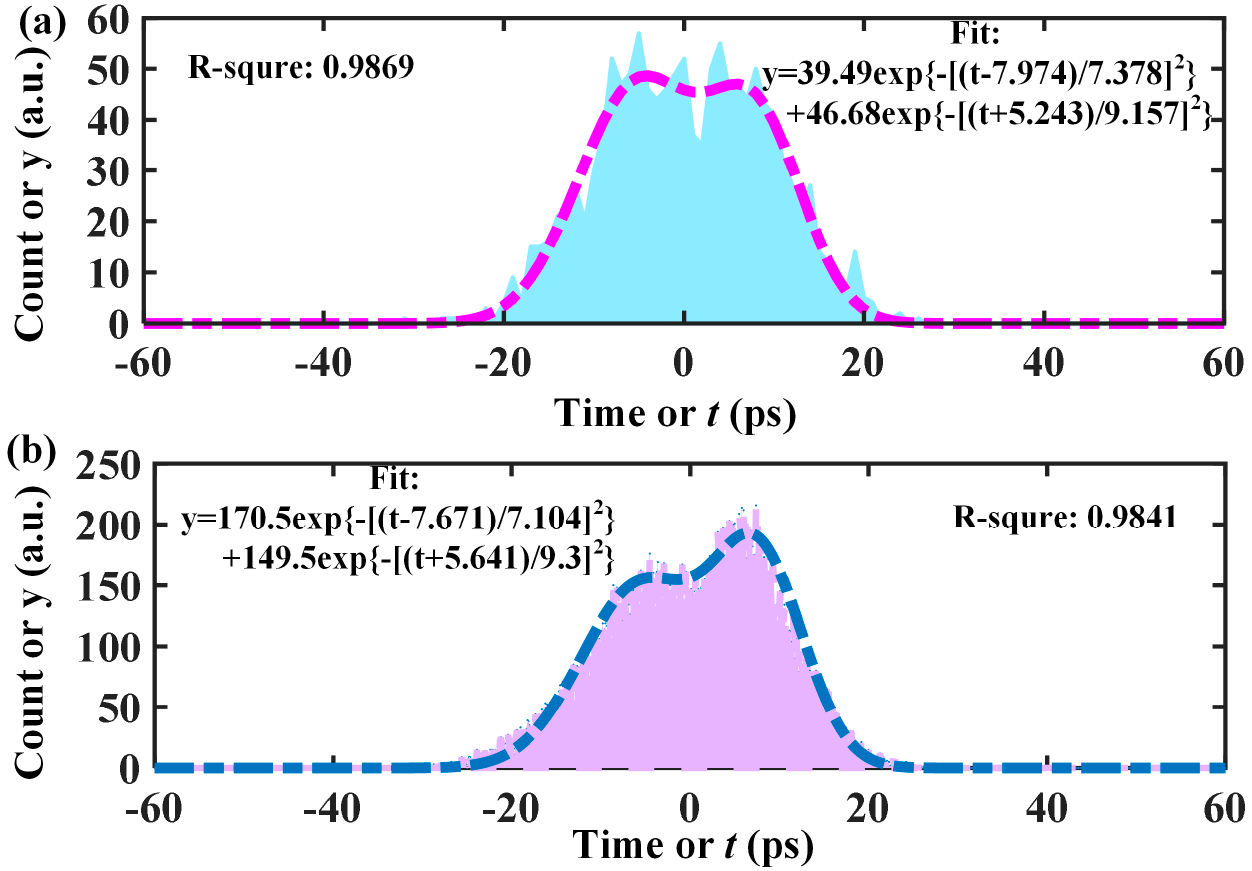
Figure 5. The measured time jitter histograms by ( a ) the proposed time jitter analysis method, and ( b ) the oscilloscope SDA 820Zi ‐ B.